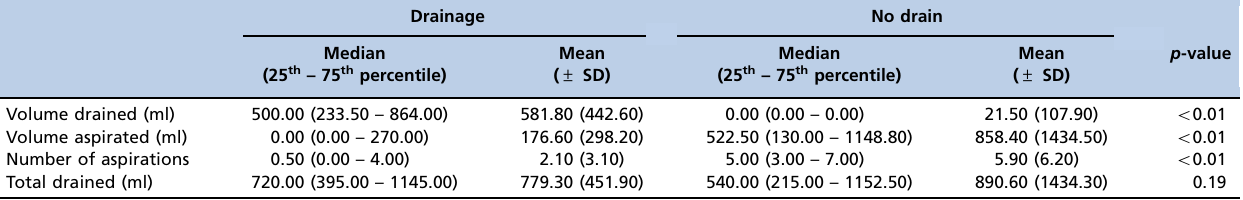
Table 2 - Comparison of the volume of drained and aspirated serous fluid in the drainage and no drain groups.* Drainage